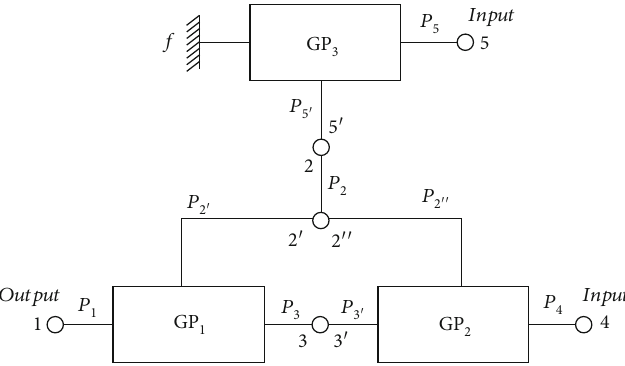
Figure 5: Scheme of the gearing system shown in Figure